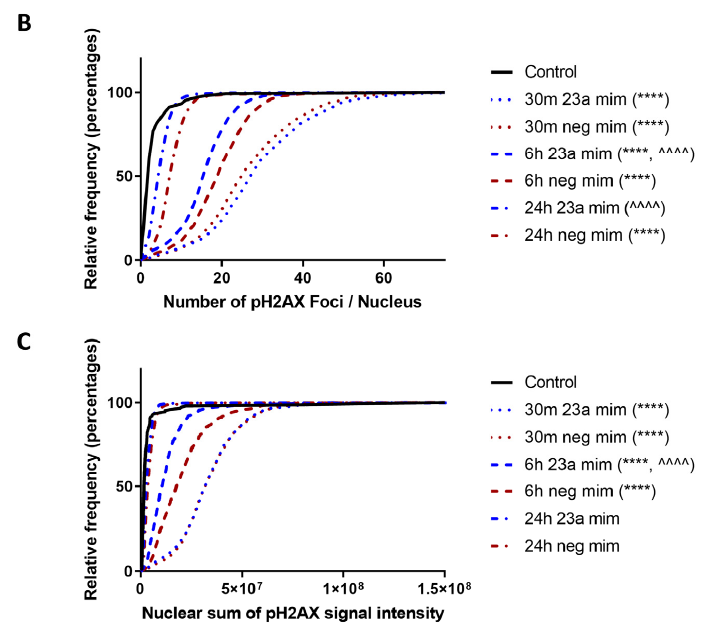
Figure 7. miR-23a-3p attenuates DNA damage response in primary cortical neurons following irradiation. Representative microscopy images from 30 min, 6 h, and 24 h of RCNs stained for γ -H2A.X (red), and 4 ′ ,6-diamidino-2-phenylindole (DAPI) (blue) ( A ). Data were calculated and plotted for all fields together as a cumulative frequency distribution without binning for γ -H2A.X foci count ( B ) and nuclear staining intensity ( C ). Eight fields were acquired per treatment as detailed above, and an average of 117 nuclei were identified per field.